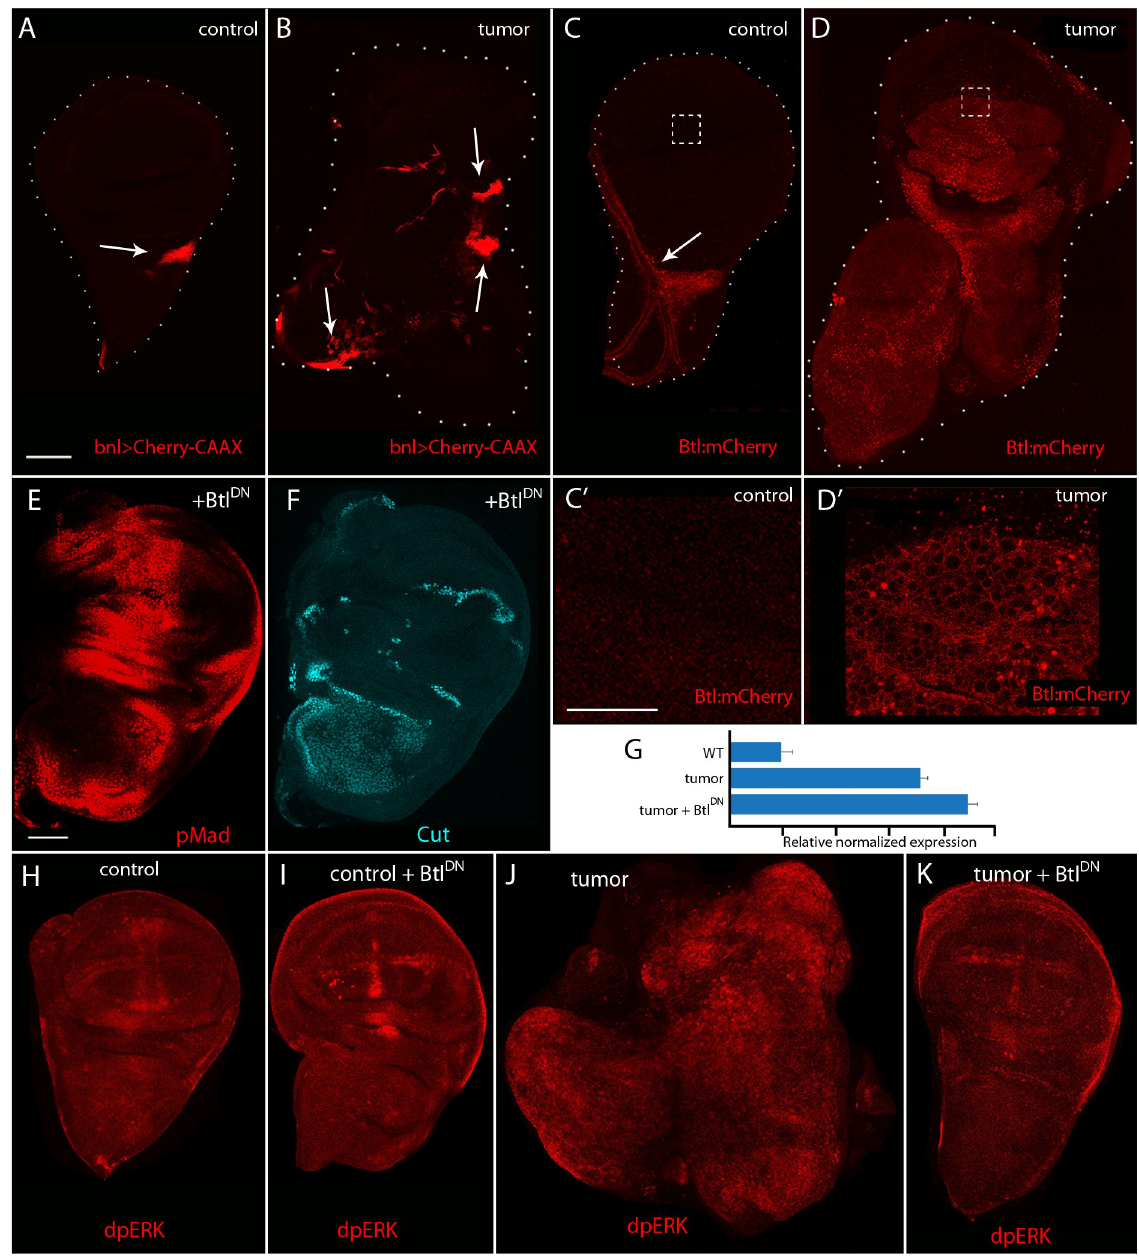
Fig 5. FGF signaling in the EGFR-Pcn tumor model. (A-B) Unfixed wing discs with Bnl-expressing cells marked with Cherry-CAAX (red, arrows). (A) Control, genotype: bnl-lexA , lexO-mCherry : CAAX/+ . Scale bar: 100 μ m. (B) EGFR-Pcn tumor, genotype: ap-Gal4 , UAS-psq UAS-EGFR , tub-Gal80 ts /bnl-lexA , lexO-mCherry : CAAX .Arrows indicate FGF up-regulation (red). (C-D’) Unfixed wing discs with Btl distribution marked by Btl:mCherry (red, arrows). (C) Control, genotype: Btl : mCherry /+. Btl is only expressed in the tracheal cells. Scale bar: 100 μ m (C’) Higher magnification image of the boxed area in (C). (D) 5 day EGFR-Pcn tumor disc, genotype: ap-Gal4 , UAS-psq RNAi / UAS-CD4-mIFP;UAS-EGFR , tub-Gal80 ts /Btl : mCherry . Btl expression is upregulated in the tumor cells. (D’) Higher magnification image of the box area in (D). Scale bars: 50 μ m. (E-F) EGFR-Pcn tumor +Btl DN fixed wing disc stained with α -phosphorylated MAD (pMad, red) antibody to monitor Dpp signaling (E) and α -Cut (cyan) to label myoblasts (F). Scale bar: 100 μ m. Genotype: ap-Gal4 , UAS-psq Gal80 ts /UAS-Btl DN . (G) EGFR mRNA measured by quantitative real-time PCR. RNA was extracted from 5 discs of the indicated genotypes. Data were normalized to rp49. The data show mean ± SD from three technical replicates of a representative experiment. Significance was analyzed using Student’s t-test (p < 0.001). Comparable results were obtained in 3 independent biological replicates. Genotypes are ap-Gal4 , UAS-CD8 : GFP (WT), ap-Gal4 , UAS-psq RNAi /+;UAS-EGFR , tub-Gal80 ts / UAS-CD8 : GFP (tumor) and ap-Gal4 , UAS-psq RNAi /+;UAS-EGFR , tub- Gal80 ts /UAS-Btl DN . (H-K) Fixed wing disc stained with α -phosphorylated ERK to monitor EGF signaling (dpERK, red). (H)